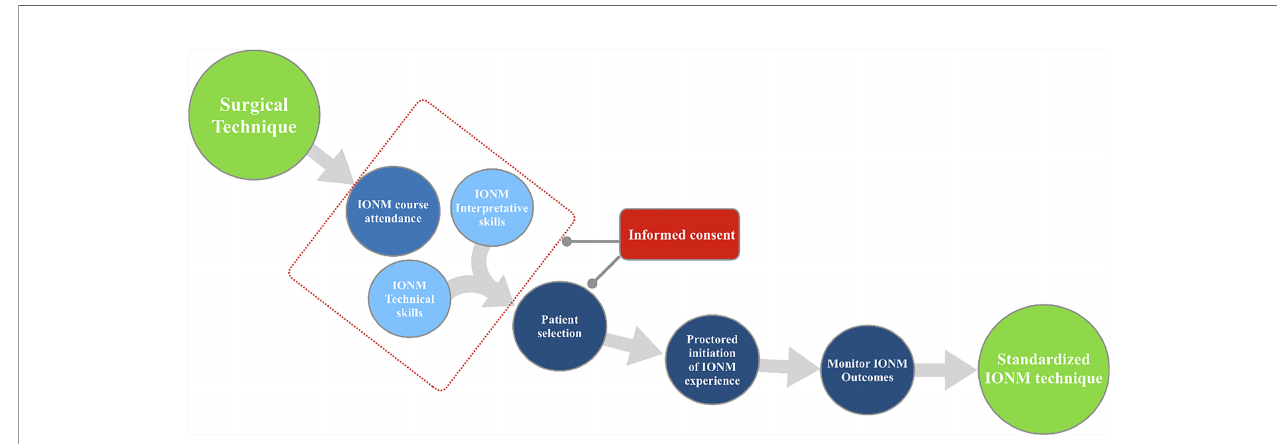
FIGURE 2 | Standardization of IONM during thyroid and parathyroid surgery. IONM speci fi c informed consent is an essential topic to be discussed during formal INMSG courses. Informed consent must be offered to all patients in whom IONM is